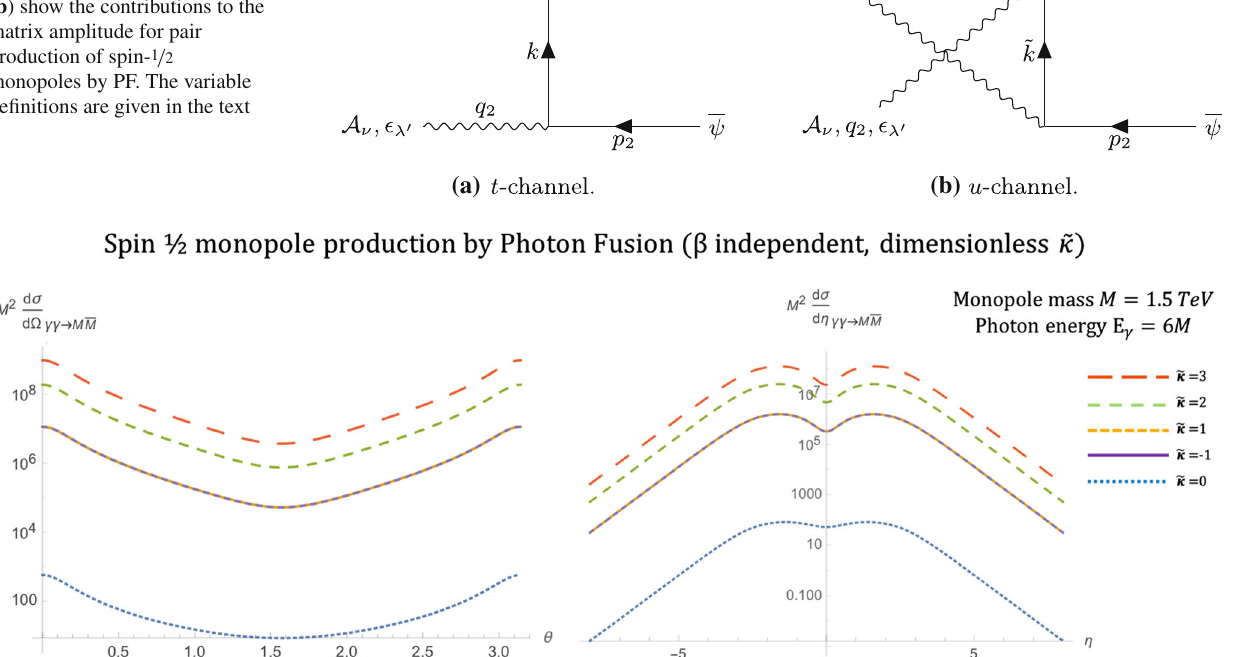
Fig. 8 Feynman-like graphs for the t -channel ( a ) and u -channel ( b ) show the contributions to the matrix amplitude for pair production of spin- 1 / 2 monopoles by PF. The variable definitions are given in the text